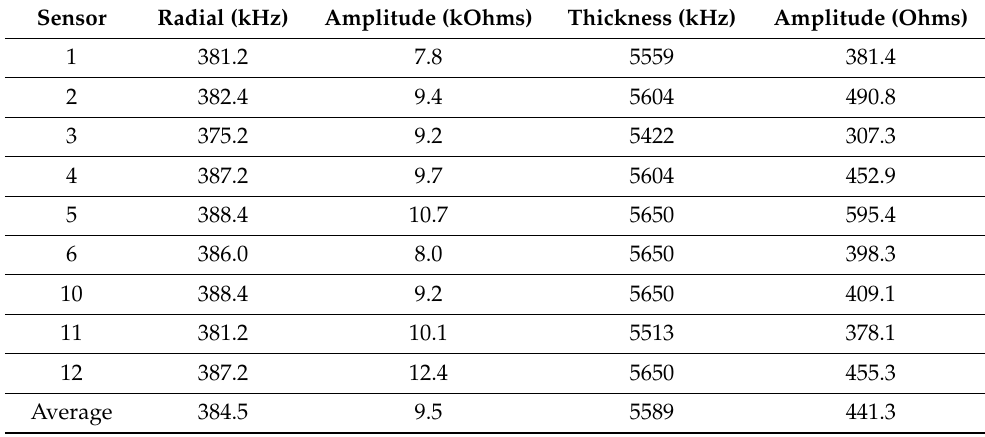
Table 1. Free sensor measured impedance